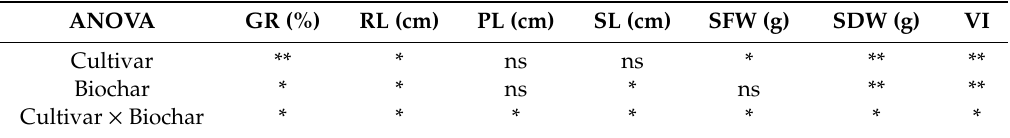
Table 2. Analysis of variance (ANOVA) of germination rate (GR), radicle length (RL), plumula length (PL), seedlings length (SL), seedling fresh weight (SFW), seedling dry weight (SDW), and vigor